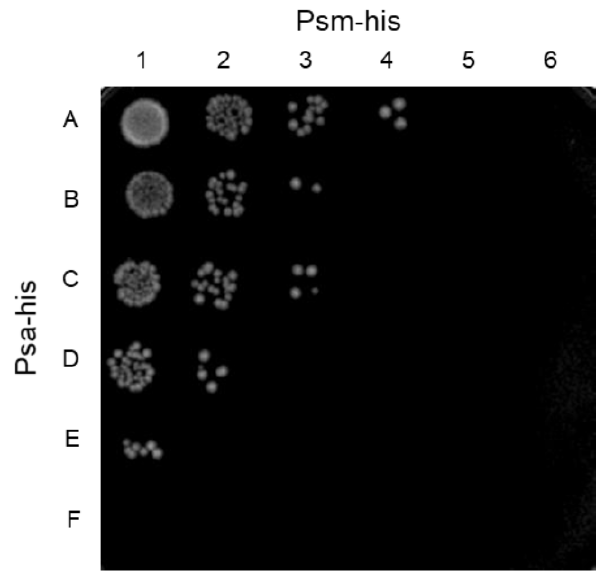
Figure 5. Synergistic killing by Psa-his and Psm-his of C. perfringens HN1314 in a checkerboard assay. Serial 2-fold dilutions with PBS (-) of Psa-his and Psm-his (20 µ L; individually and in combination) were mixed with 20 µ L (4 × 10 6 cells) of C. perfringens HN1314 on ice. After a 30-min incubation at 37 ◦ C, 2 µ L (2 × 10 5 cells) of each mixture were spotted to GAM/2 agar plates and incubated anaerobically at 37 ◦ C for 12 h. Rows A-F are Psa-his concentrations of 4.3, 8.7, 17.3, 34.6, 69.2, and 138.5 nM. Columns 1-6 are Psm-his concentrations of 1.0, 1.9, 3.9, 7.8, 15.5, and 31